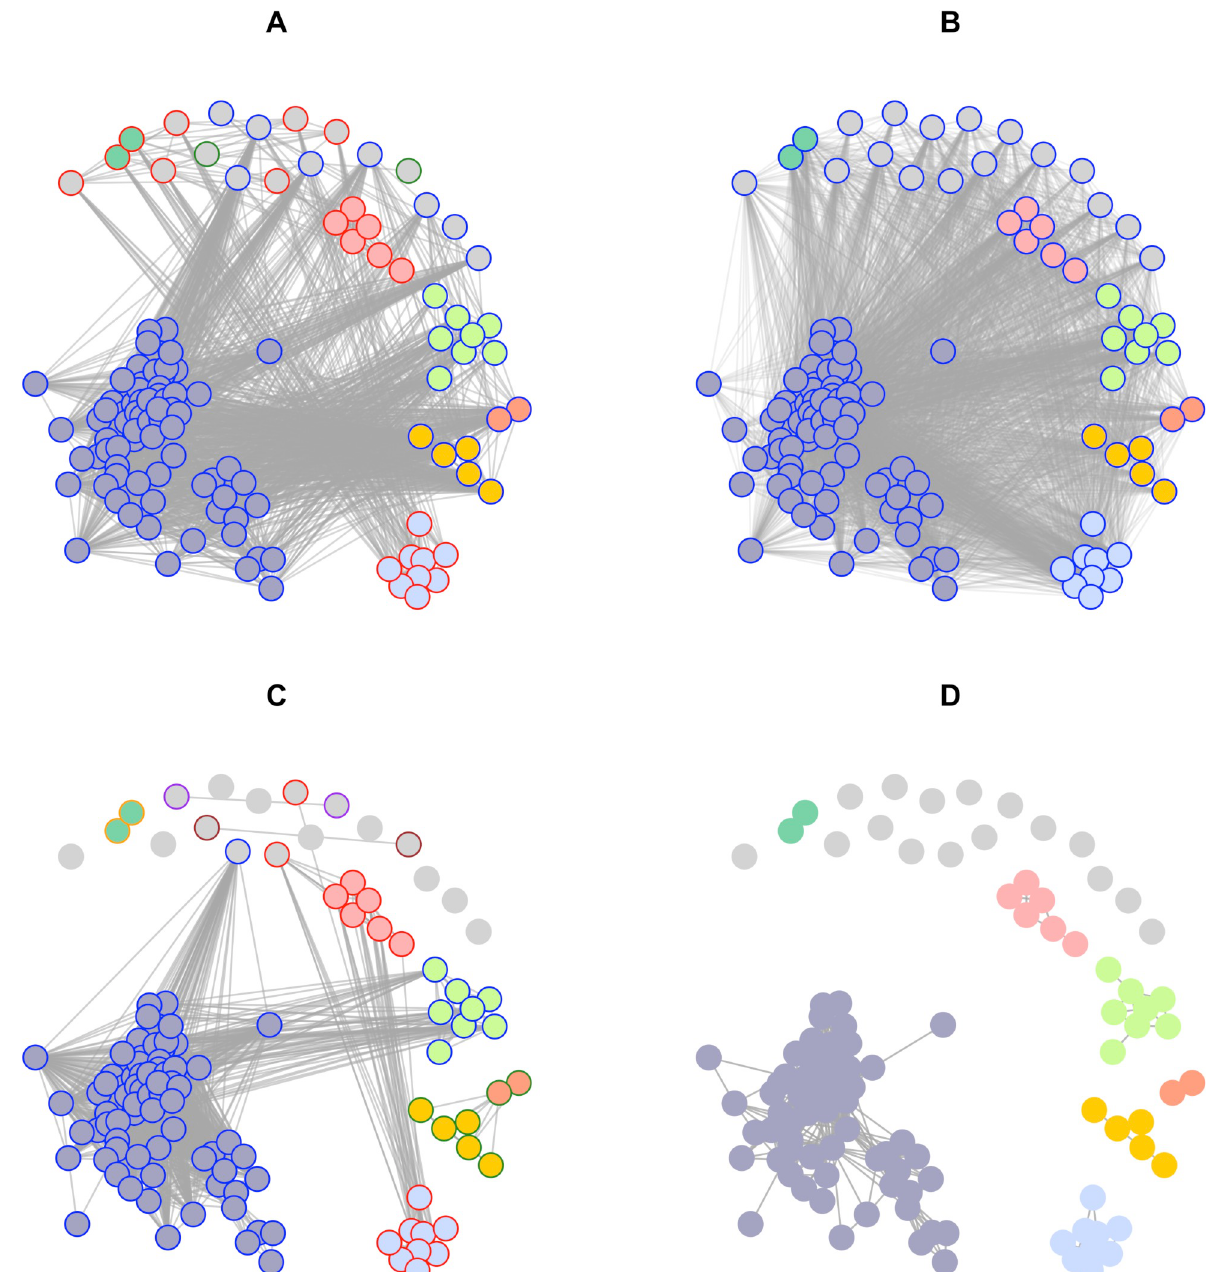
Fig 4. Pruned (A-C) and final graph (D) used to define clusters of cases in the rabies outbreak, obtained using A) only temporal distances, B) only spatial distances, C) only genetic distances and D) all three combined. Nodes represent cases, and edges potential epidemiological links, according to the corresponding data. The inner colours of the nodes indicate the final clusters obtained by combining all data streams (D), whilst the outer colours correspond to the clusters obtained using one data stream at a time. Grey indicates singletons. A reporting rate of 20% was assumed, and pruning cutoff distances corresponding to the 95% quantiles of the input distance distributions were used (see S1 Text for sensitivity analyses on these assumptions). In each graph, the transparency of the vertices was adjusted according to the number of vertices in the graph, with more transparency in graphs with more vertices, to improve